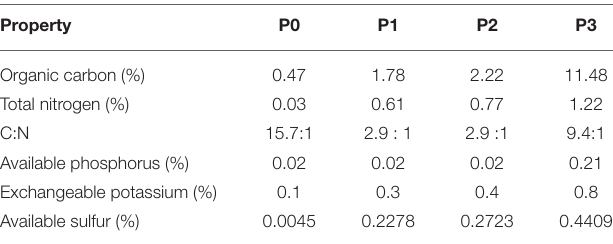
TABLE 1 | Nutrient composition of the growing media (P0: control, 100% soil; P1: 40% soil + 40% vermicompost + 20% cocodust; P2: 50% soil +